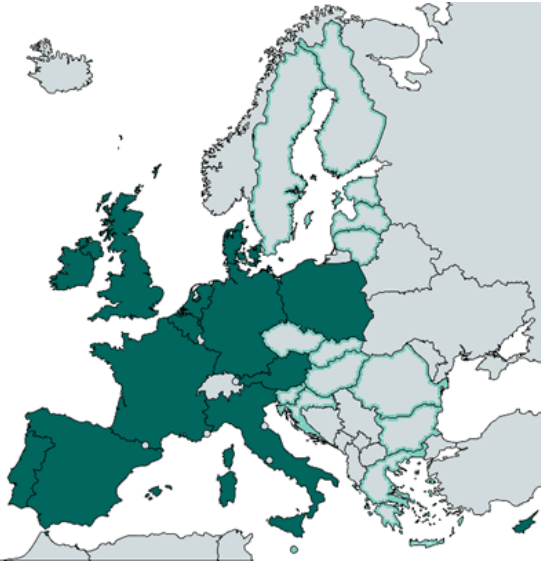
Figure 1: REELER case variation across